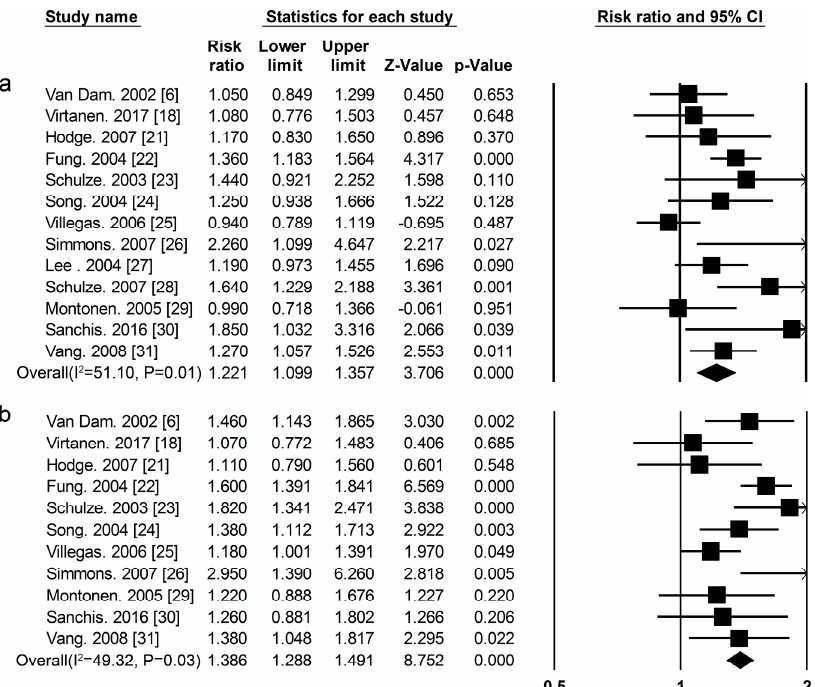
Figure 4. Plant protein and type 2 diabetes RRs for ( a ) the highest vs. the lowest intake in all subjects and ( b ) the highest vs. the lowest intake in men ( c ) the highest vs. the lowest intake in women. The RR of each study is represented by a square, 95% CI are represented by the horizontal lines, and the diamond represents the estimate and its 95% CI.